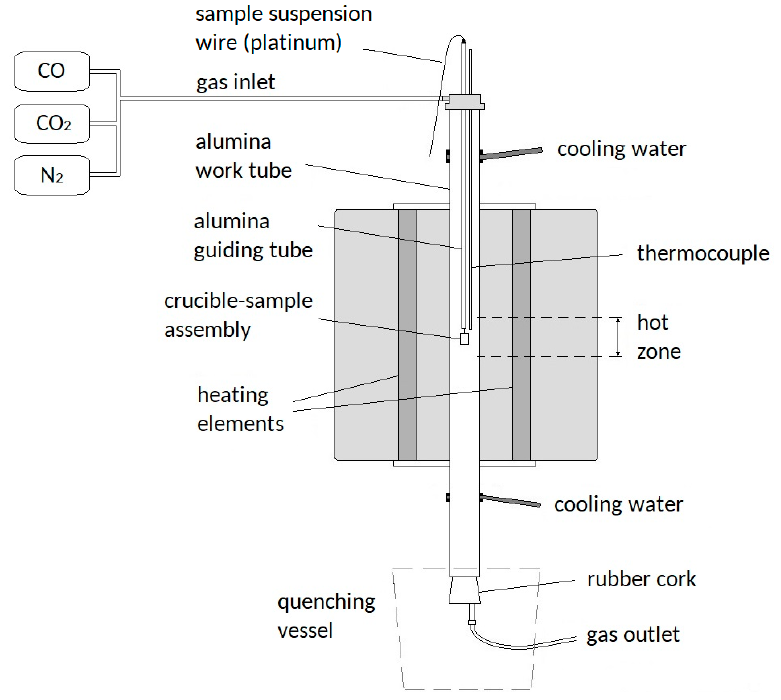
Figure 1 . A schematic of the experimental furnace set-up. Figure 1. A schematic of the experimental furnace